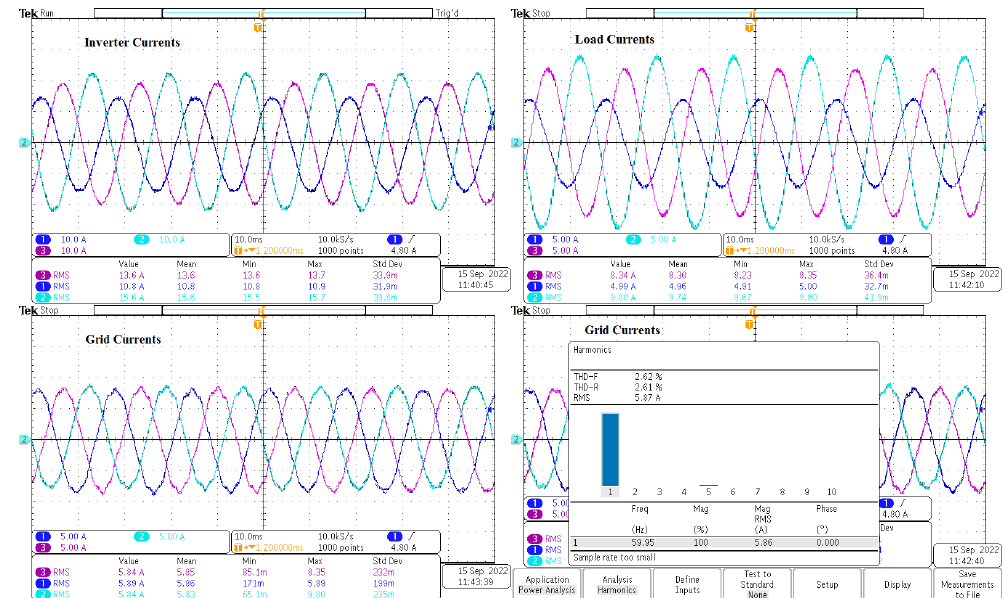
Figure 19. Hardware results using dSPACE Controldesk for real power = 2 kW and reactive power = 0 kvar under balanced grid inductances.